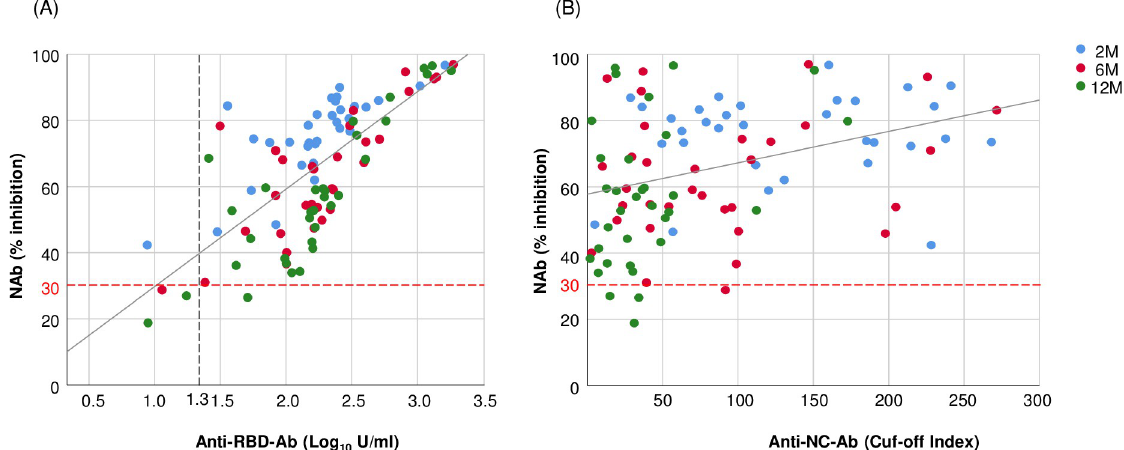
Fig 2. Correlations of the neutralizing antibody (NAb) with anti-RBD-Ab and anti-NC-Ab. (A) Correlation between the NAb and the anti-receptor-binding domain antibody (anti-RBD-Ab). The cutoff for anti-RBD-Ab, Log 10 (0.8) = –0.0969, is not shown in the graph. Spearman’s rank correlation coefficient: 2M: rho = 0.739; 6M: rho = 0.707; 12M: rho = 0.801; in total: rho = 0.736; all P < 0.001. Blue dots: data at 2 months after the outbreaks of COVID-19 at workplaces (2M); red dots: data at 6 months (6M); and green dots: data at 12 months (12M). The solid line represents the linear regression. The red dotted line indicates the cutoff of NAb. The black dotted line indicates the suggested threshold of anti-RBD-Ab to determine the positivity of NAb. (B) Correlation between the NAb and the anti-nucleocapsid antibody (anti-NC-Ab). The cutoff for anti-NC-Ab is Cut off index (COI) ≧ 1.0. Spearman’s rank correlation coefficient: 2M: rho = 0.062, p = 0.73; 6M: rho = 0.129, p = 0.48; 12M: rho = 0.268, p = 0.13; in total: rho = 0.355, P < 0.001.